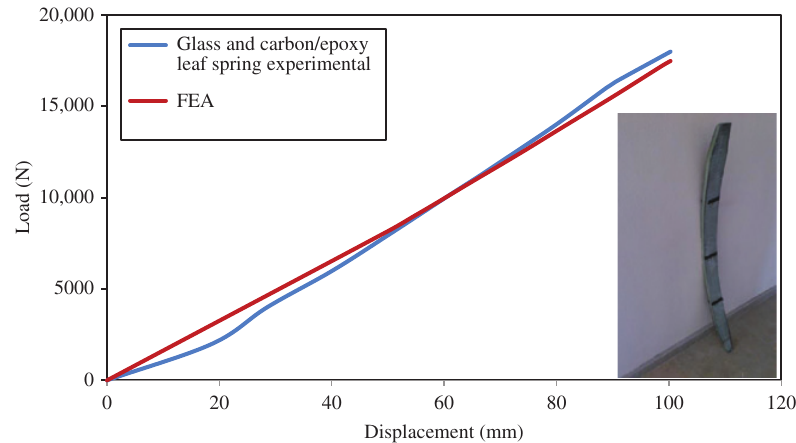
Figure 17: Predicted and experimental load-displacement response of Prototype 2.